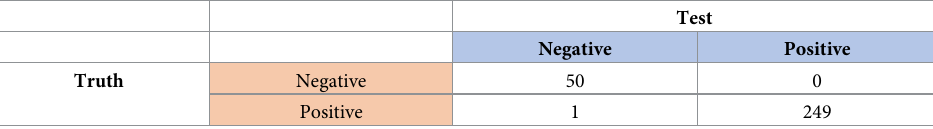
Table 2. Specificity and sensitivity of the test based on results from 30 blinded samples (5 negative and 25 posi- tive) and the 10